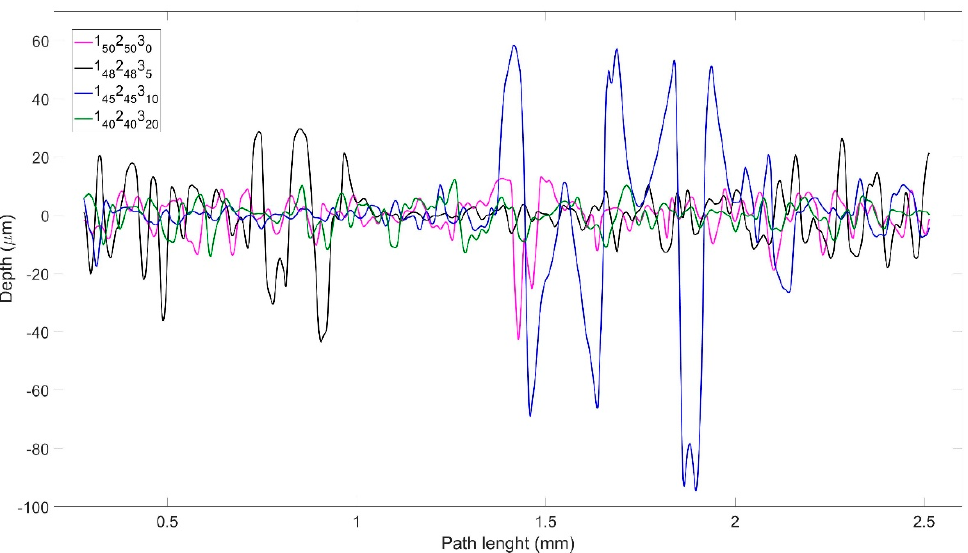
Figure 5. Topographical analysis of surface roughness of cured laminates with different POSS content.